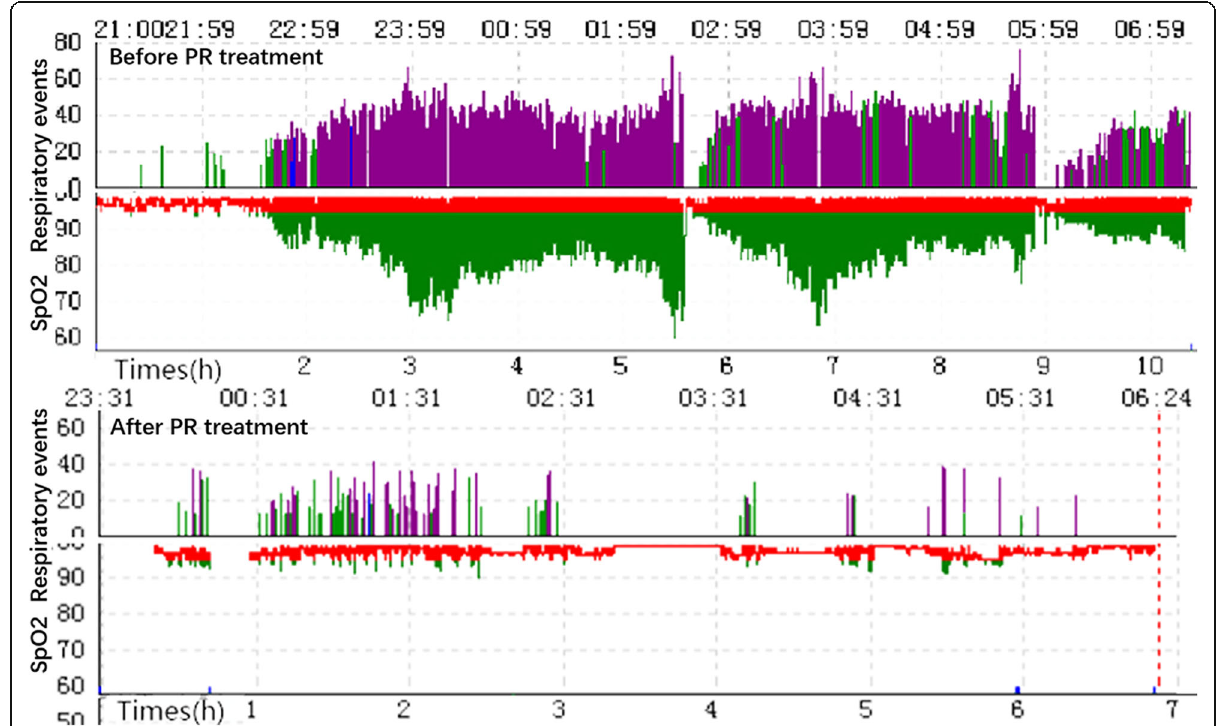
Fig. 2 Polysomnogram analysis obtained before and after pulmonary rehabilitation treatment